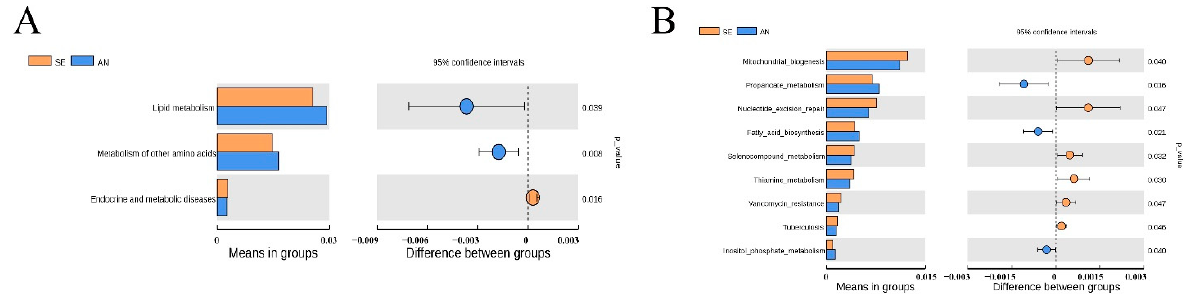
Figure 11. Differently enriched microbial biological functions between AN and SE samples at KEGG level 2 ( A ) and level 3 ( B ).